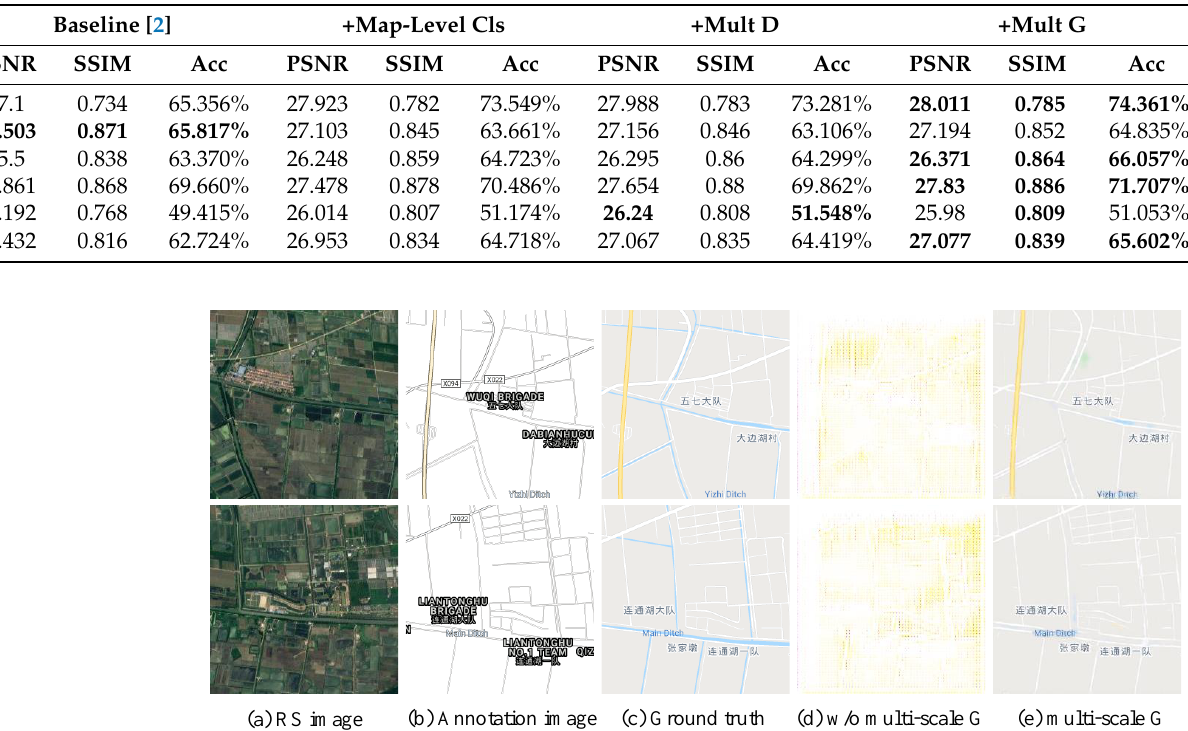
Table 6. Ablation study of the proposed CscGAN. Impact of integrating our different components (Level Cls, Mult D, and Mult G) into the baseline on the RS-image-to-map dataset for ablation experiments. +Map-level Cls: Add a level classifier to pix2pix. +Mult D: Add a multi-scale discriminator based on the previous model. +Mult G: Add a multi-scale generator based on the previous model. Note: The best results are presented in bold.